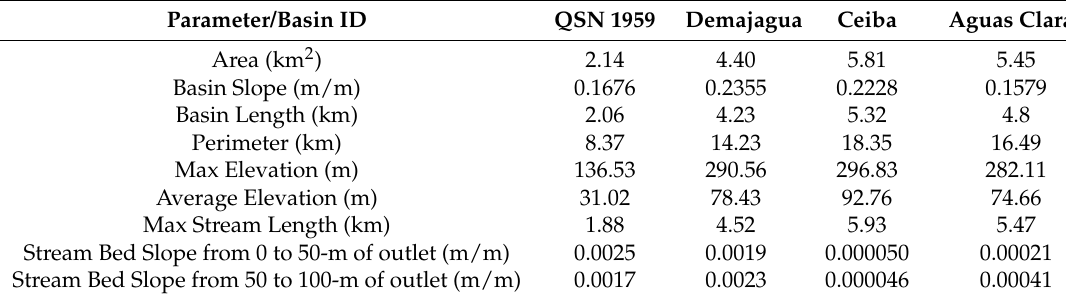
Table 3. Basin parameters for the watersheds at the area of interest.